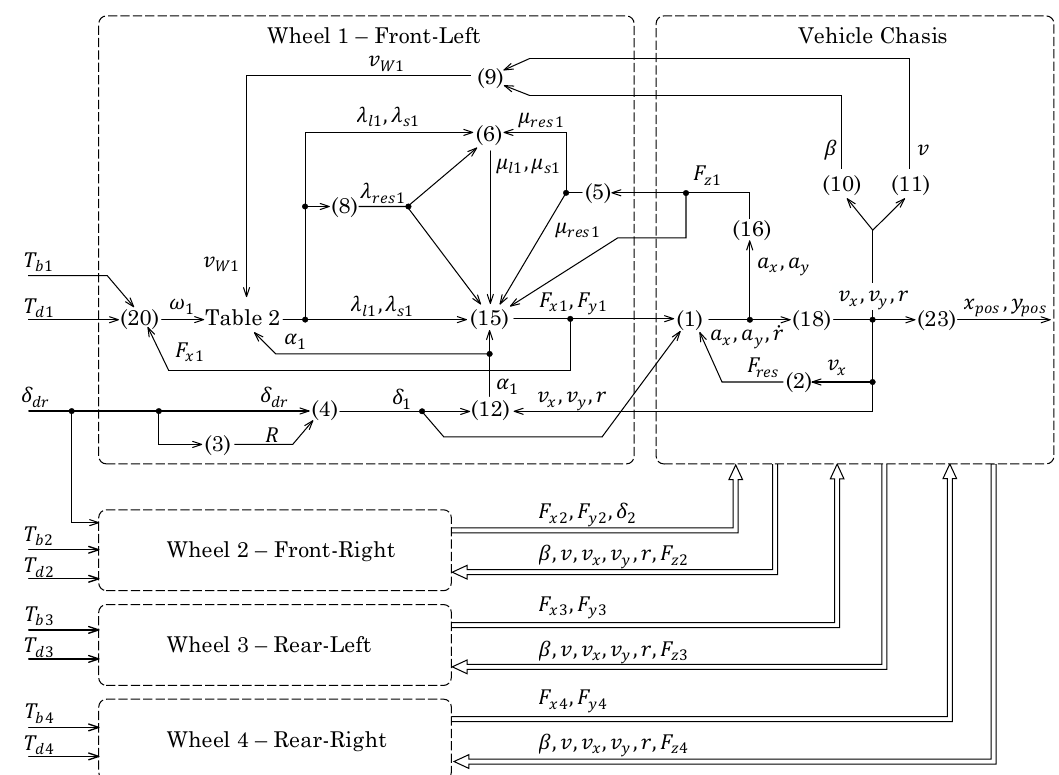
Figure 9. Calculation flow for 4-wheel-driven EV simulation model. For simplification, the representative wheel 1 is shown. The calculation procedure for other wheels is identically the